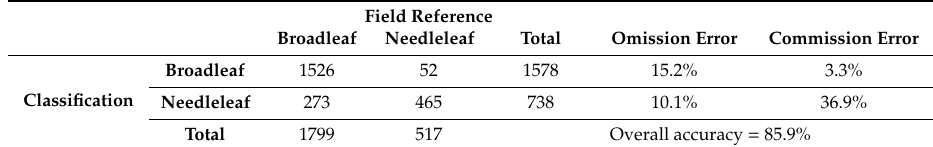
Table 2. Classification accuracy for the Random Forest algorithm applied to individual tree segmentations using high-density drone